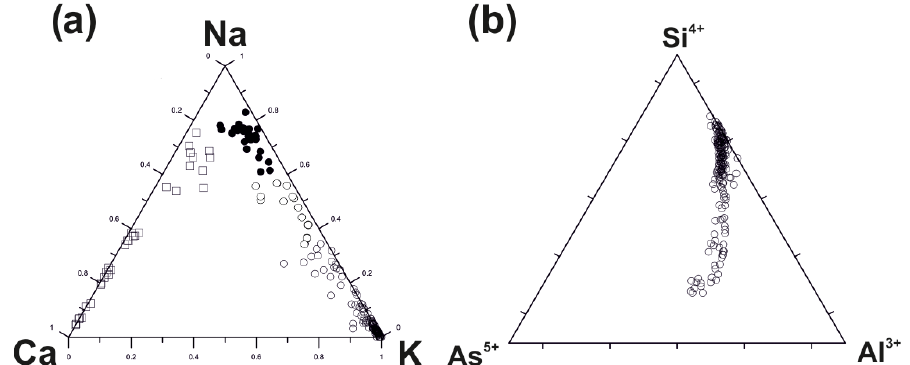
Figure 1. Ratios of major extra-framework cations in fumarolic feldspars from the Arsenatnaya fumarole: (cid:13) – sanidine (including Na sanidine within the limits Or 70 – Or 40 , according to classification by Deer et al. (2001), • – anorthoclase (Or 40 – Or 90 ) , (cid:3) – plagioclases (andesine, labradorite, bytownite and anorthite) (a) ; ratios of major tetrahedrally coordinated components in sanidine–filatovite series from the Arsenatnaya fumarole (b) .